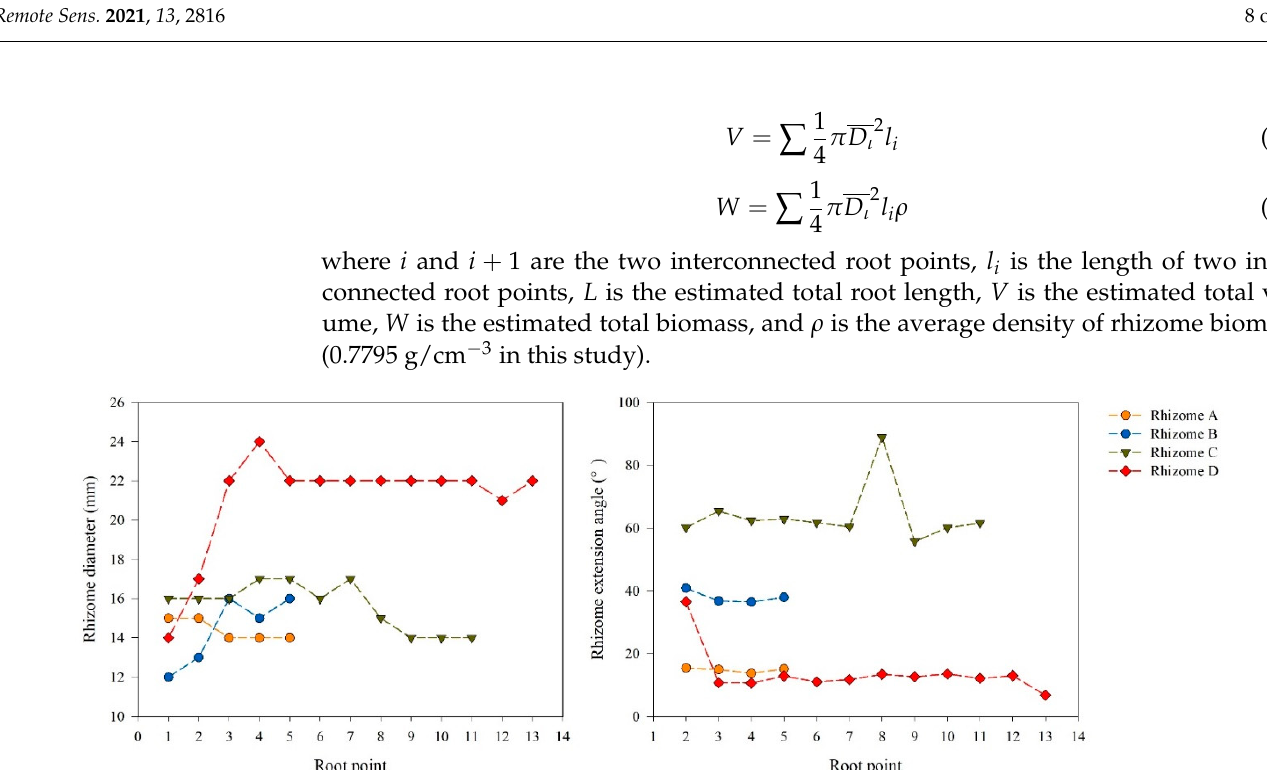
Table 1. Values of the weighting parameters a , b , and c , and associated accuracy of the root system architecture (RSA) reconstruction. Numbers in bold indicate the highest accuracy achieved for the root point connection.